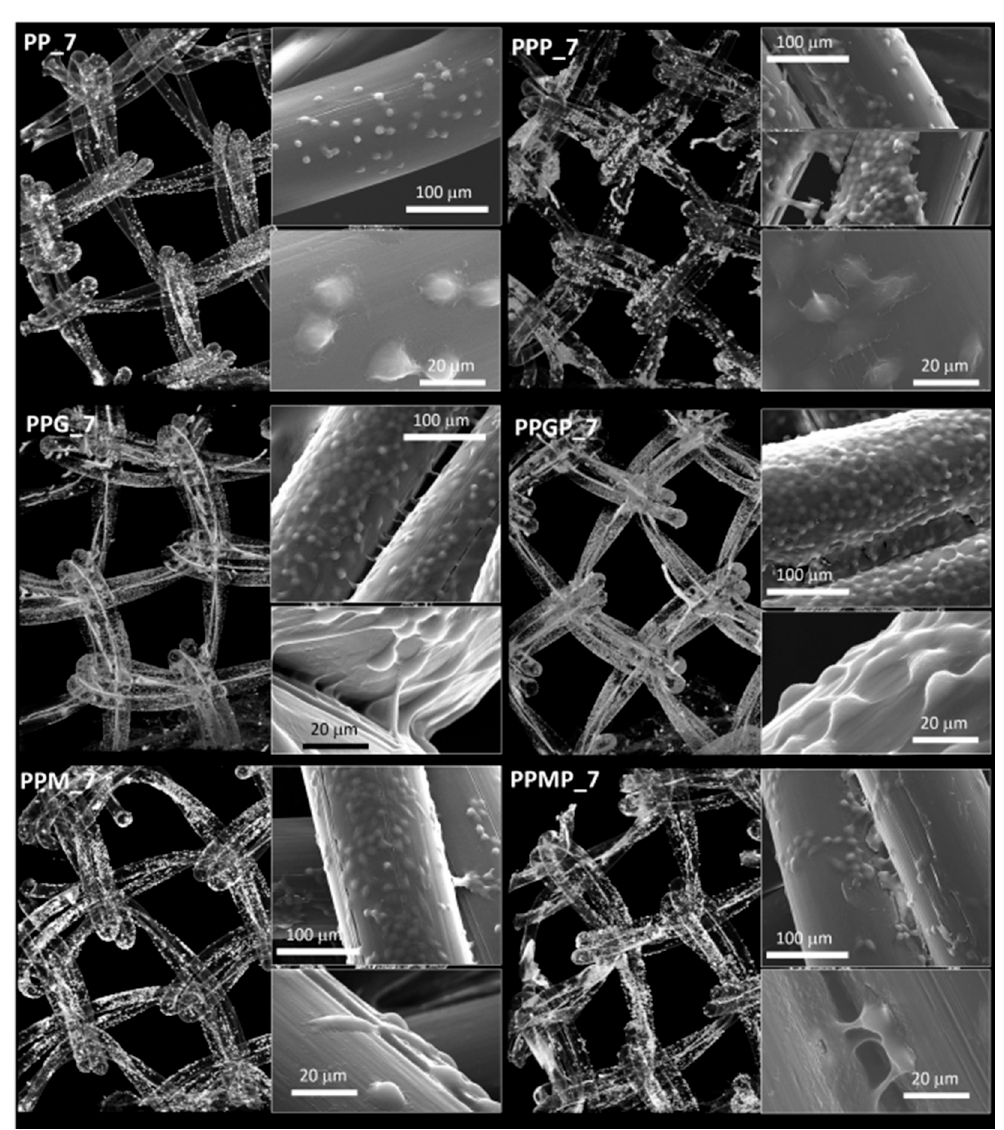
Figure 5. Micro-CT images and SEM micrographs (inset) at seven days post-seeding; left column, top to bottom—PP_7 and protein-coated PP (PPG_7 and PPM_7); right column, top to bottom—PRP-treated PP (PPP_7) and PRP-treated hydrogel-coated sample PPGP_7 and PPMP_7.